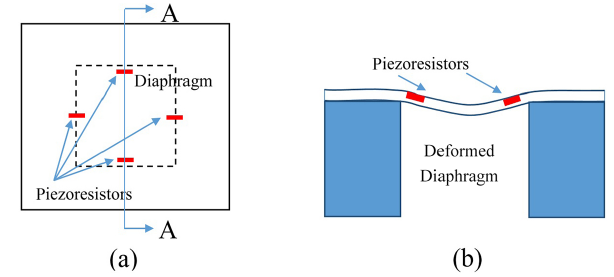
Figure 1. Typical piezoresistive pressure sensor structure. (a) Top view of the piezoresistive pressure sensor. Four piezoresistors are placed on each edge forming a Wheatstone bridge circuit. (b) Cross section A–A showing deflected diaphragm with piezoresistors at maximum stress locations (Barlian et al., 2009).